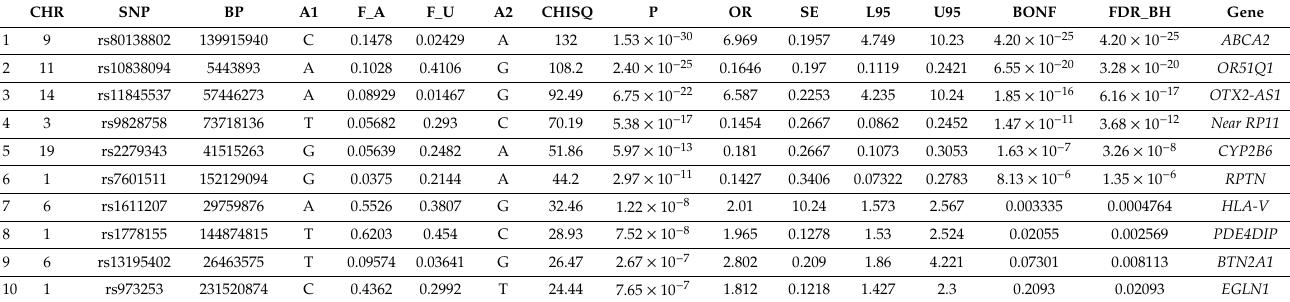
Table legend: CHR—chromosome, BP–base pair based on the human reference genome GRCh37, A1—minor allele, A2—major allele, F_A—frequency of A1 allele in patients, F_U—frequency of A1 allele in controls, CHISQ—Basic allelic test chi-square (1df), P— p -value for CHISQ, OR—odds ratio, SE—Standard Error, L95 and U95—95% confidence interval for